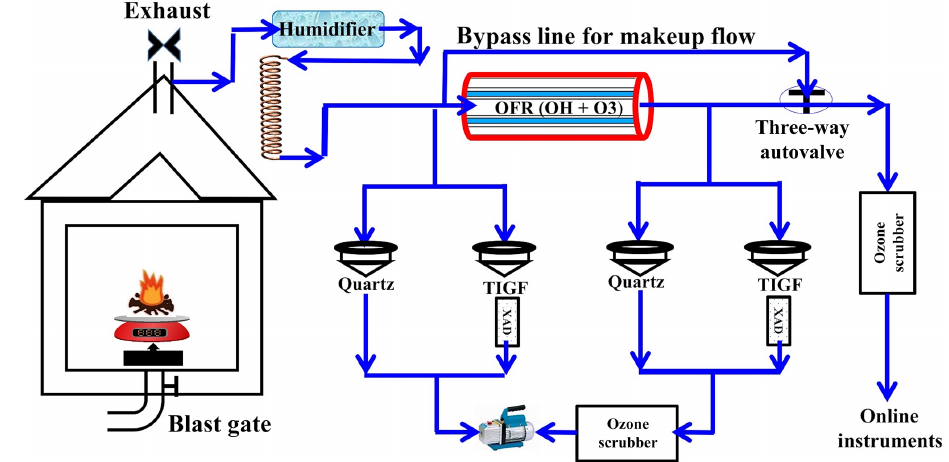
Figure 1. Desert Research Institute (DRI) biomass-burning (BB) facility with oxidative flow reactor (OFR) and flow